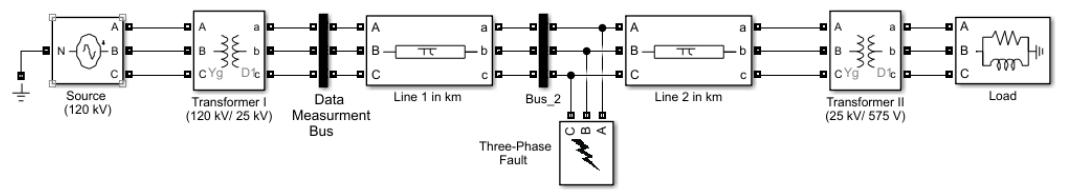
Figure 4. Simulink model for the distribution grid.